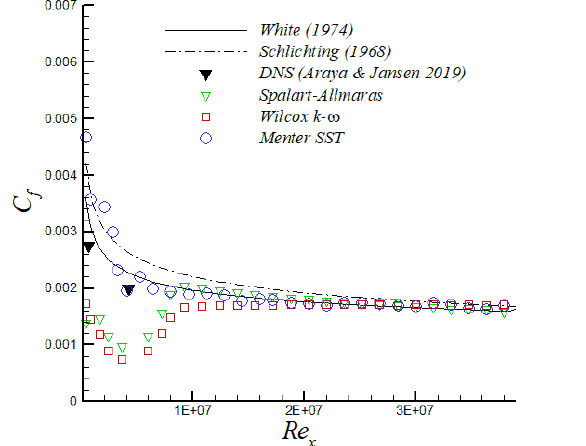
Figure 2. Skin friction coefficient as a function of Re x